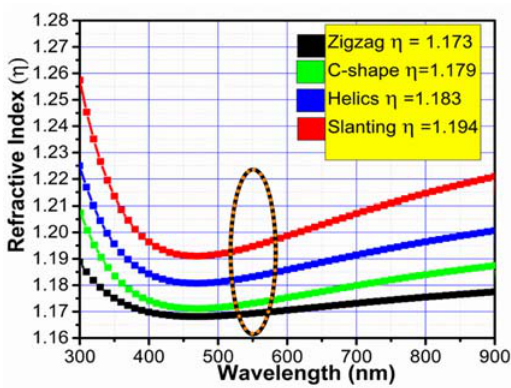
Figure 2. Refractive index ( η ) of SiO 2 nanozigzag, nanohelix, slanting and C ‐ shape nanofilms measured as a function of wavelength at 550 nm.